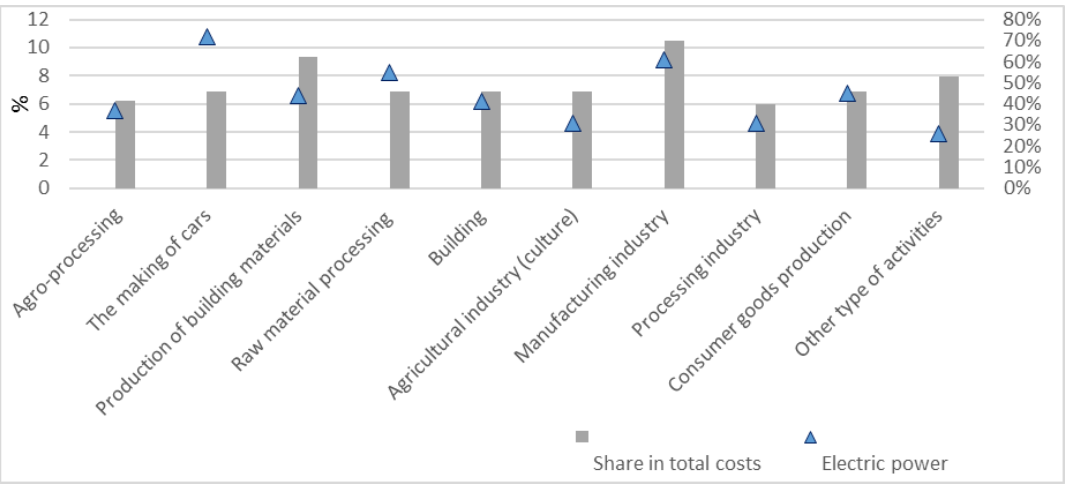
Figure 3. Effect of energy costs in production. Figure 3. E ff ect of energy costs in